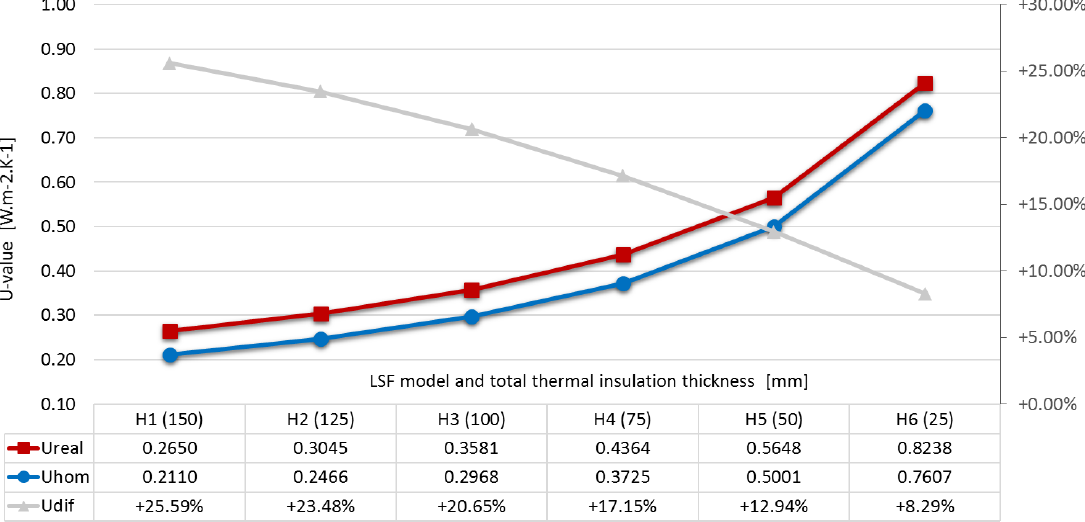
Figure 7. Thermal transmittance values obtained for LSF hybrid frame construction.